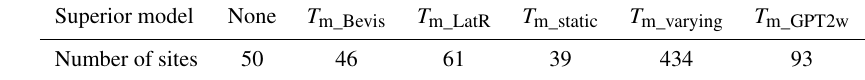
Table 3. Number of radiosonde sites at which the five global applied T m estimation models had superior performance.